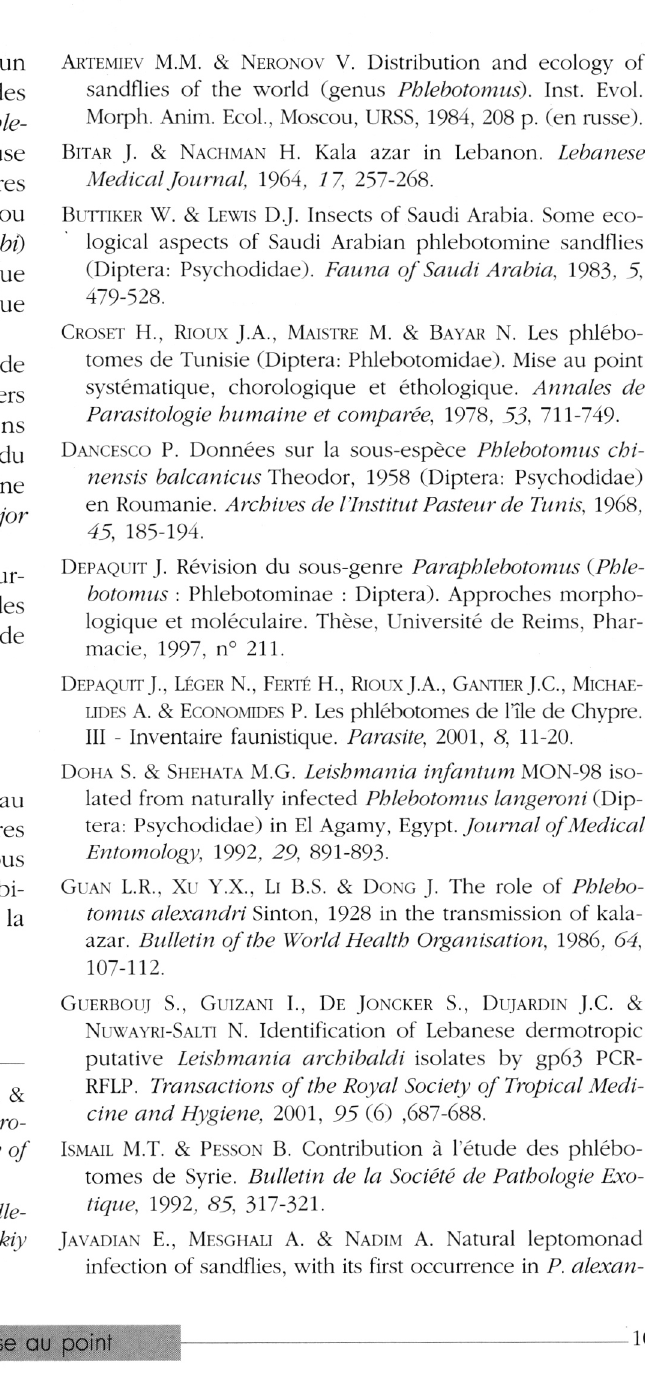
Fig. 18. - 5. palestinensis. Femelle : pha­ rynx (a) ; cibarium